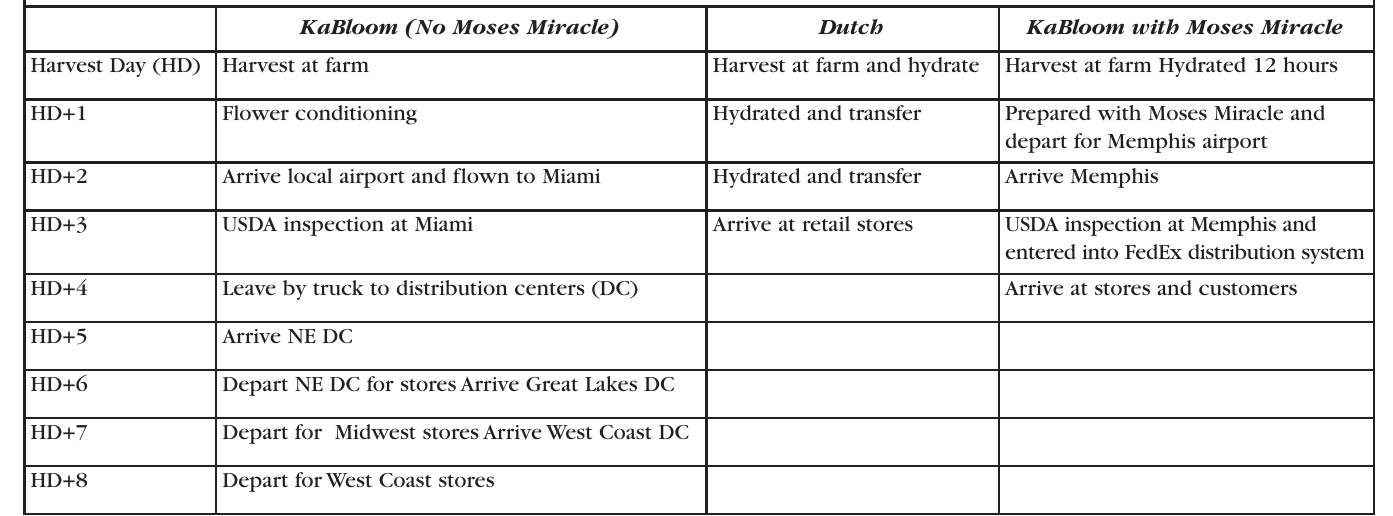
Table 9. Comparison of Distribution